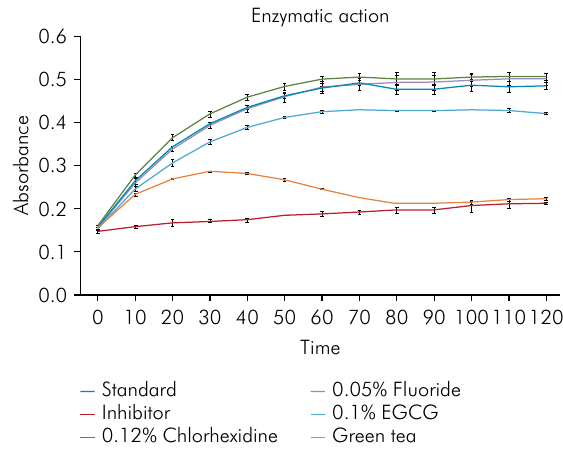
Figure 2. Residual enzymatic activity, in triplicate ( in vitro ), of MMPs (proteases extracted from dentin) treated with the Negative control, Standard inhibitor, 0.12% Chlorhexidine, 0.05% Fluoride, 0.1% EGCG, and Green tea. Absorbance x time (min). Compared to the standard inhibitor, Green tea was found to inhibit enzymatic activity throughout the 80-min incubation period.